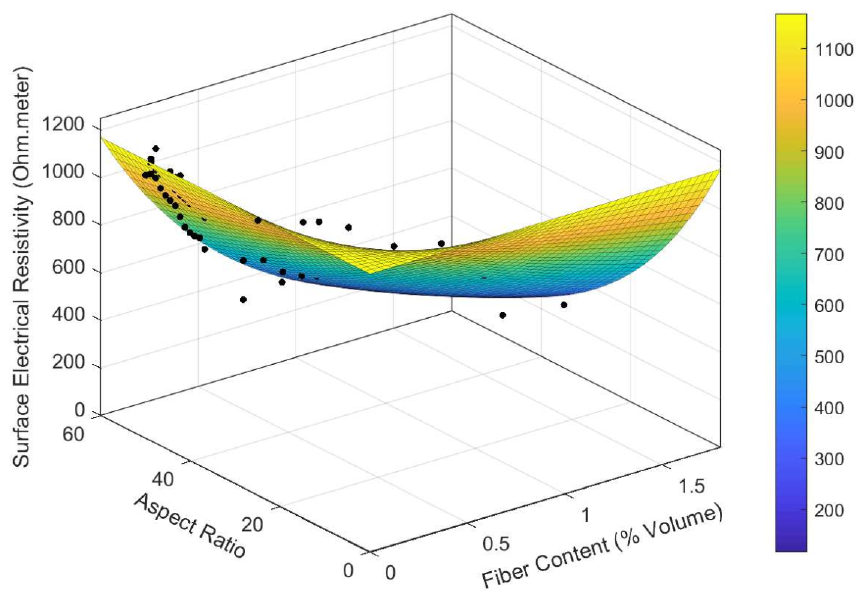
Figure 9. The electrical resistance for different percentages of fiber